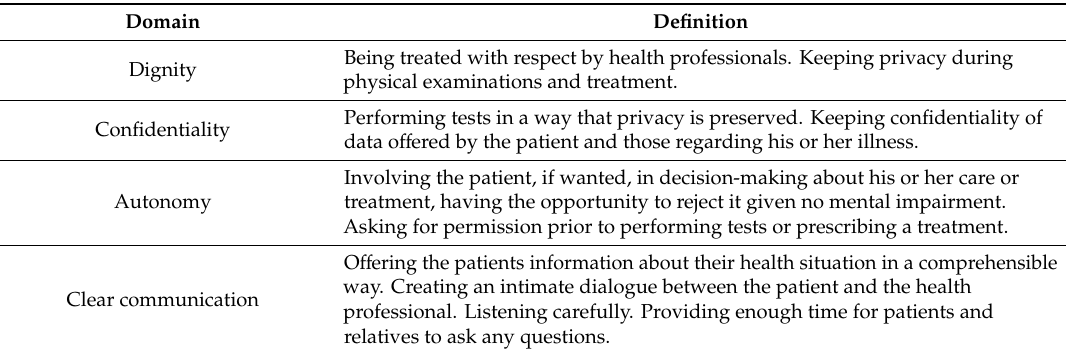
Table 1. Responsiveness domains regarding respect for persons.